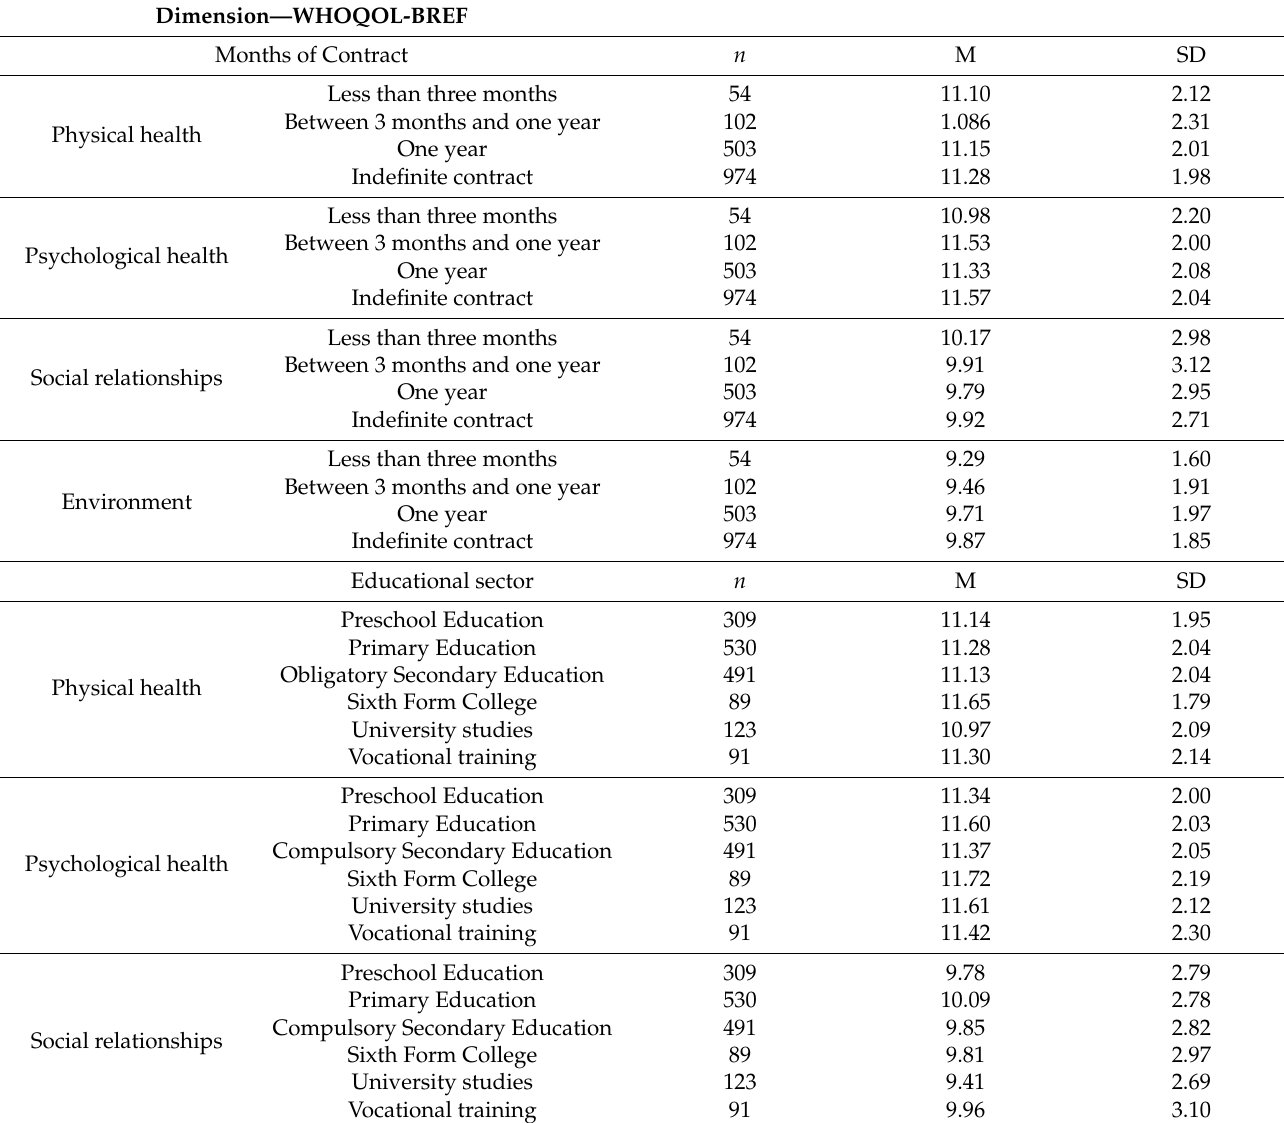
Table 5. Means and standard deviations in quality-of-life scores according to length of contract in months (job stability) and